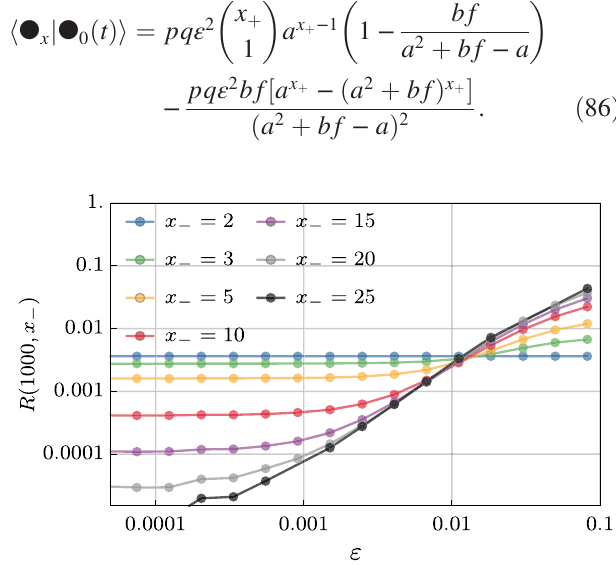
; x − Þ [cf. Eq. (76)] for x − ≪ x FIG. 5. Relative error R ð x as a þ þ function of ε . The gate is fixed to gate 2 from Table I for x ∈ Z and density of defects δ ¼ 1